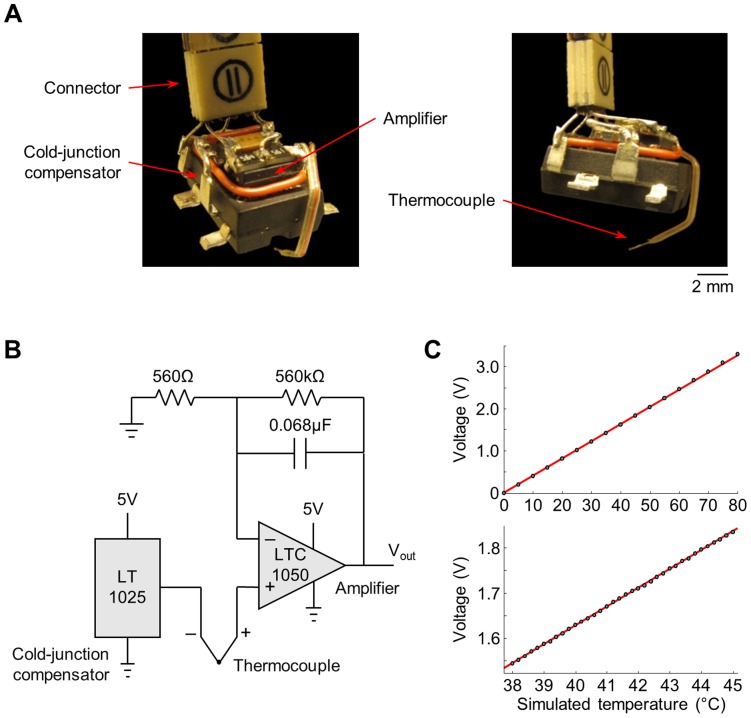
Method for recording brain temperature in freely behaving zebra finches.(A) Photographs of the miniature device for brain temperature recordings. (B) Circuit diagram of the device. (C) Voltage output (Vout) produced by the device at a wide range of simulated temperature values (top) and at values in the physiological range (bottom). Simulated temperatures were produced by a commercial thermocouple calibrator. Symbols indicate averages of 10-s recordings; 95% confidence intervals are smaller than the symbols. Red lines are the linear fits to the data.